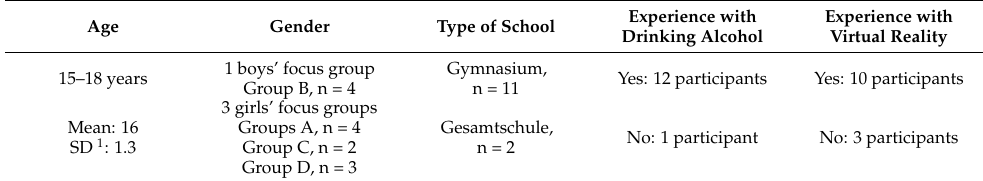
Table 1. Participants’ characteristics (n =